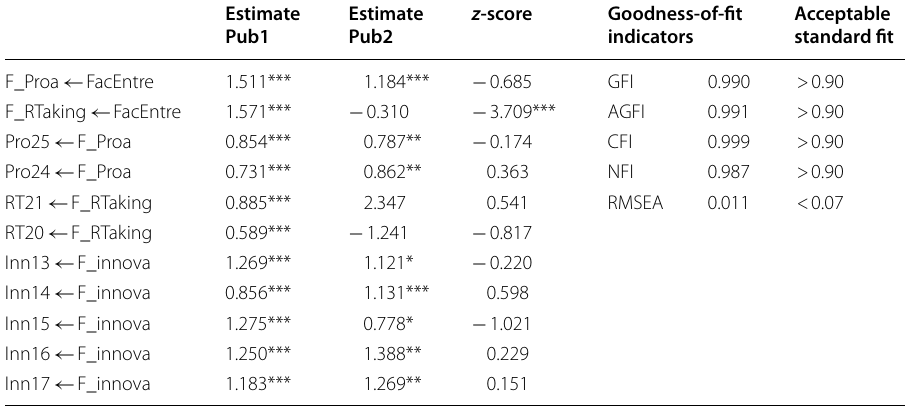
Table 9 SEM results for FEO construct subject to industrial experience